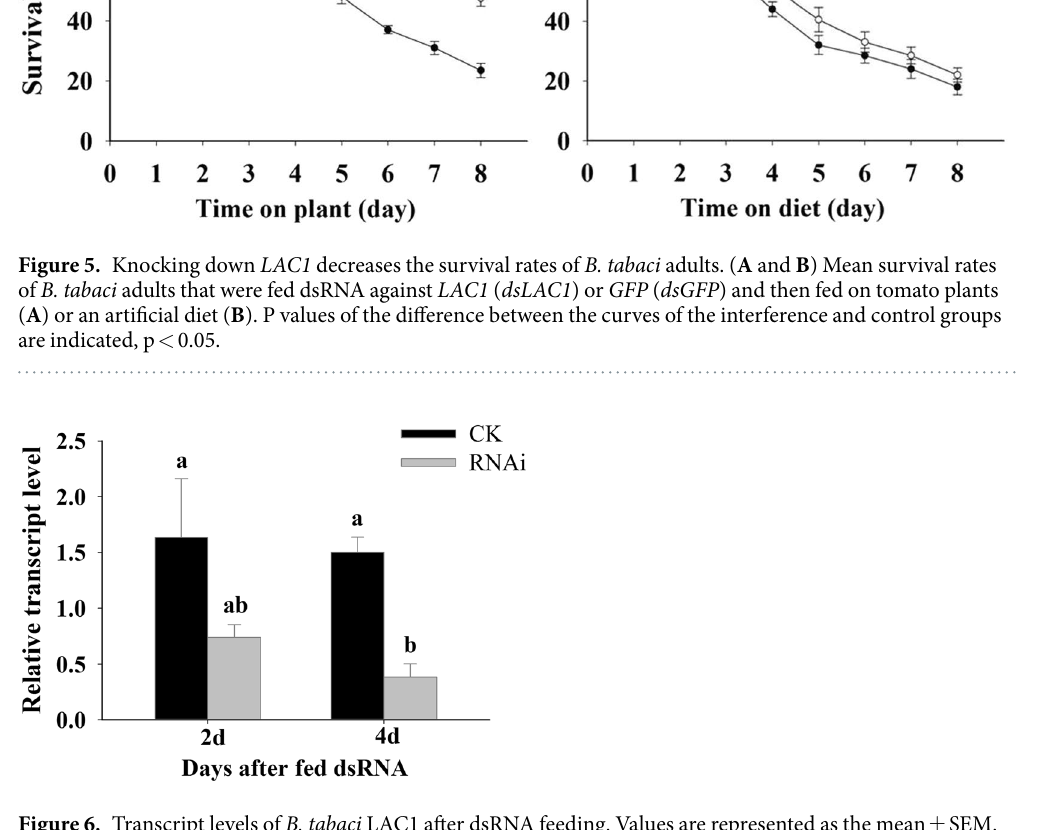
hydrolysed in vivo have not been fully elucidated in insects. To perform its catalytic function, laccase depends on Cu atoms that are distributed at three different copper centres. These copper centres in laccases are cate- gorized into three groups: Type-1 (T1), Type-2 (T2) and Type-3 (T3) 31 . The laccase genes typically have three to four of these copper domains 32 , the structure of which can vary greatly between different organisms. This extensive structural variability results in a corresponding variation in catalytic properties and oxidative func- tion 33–36 , such as their involvement in lignin biosynthesis (in plants) as well as lignin degradation (in fungi and bacteria) 31 . Laccases catalyse the oxidation of a wide array of substrates during four-electron transfer processes while reducing O 2 to water 37 . We found that LAC1 also has three different copper domains: T1, T2 and T3. This structural characteristic demonstrates that LAC1 belongs to the laccase family and has catalytic properties as well as oxidative function. In contrast to most enzymes, which catalyse substrate-specific reactions, laccases oxidize a wide range of compounds that vary from di-, poly-, and substituted phenols to diamines, aromatic amines, and benzenethiols 31, 38 . As laccases have so many kinds of substrates, LAC1 in B. tabaci may perform more than one function in vivo . Phylogenetic analyses comparing the B. tabaci MED LAC1 protein sequence to 37 other LACs from insects, fungi, bacteria, and plants showed that the B. tabaci laccases are evolutionarily unique and distinct from other insect LAC2 proteins with known or suspected roles in integument formation 23, 26, 39 . According to the phyloge- netic analysis, B. tabaci LAC1 is most similar to N. lugens MOX1 (AKN21378.1), D. citri LAC1 (XP_008487811.1), N. cincticeps LAC1 (BAJ06132.1) and A. pisum LAC1 (XP_001948070.1) (Fig. 1). This result illustrated that lac- cases of plant-sucking insects may have similar physiological functions and be evolutionarily related. ABTS is specifically oxidized by laccase 40 . We observed a significant difference in laccase activity between saliva and the control solution, indicating that the ABTS-oxidizing enzyme is laccase. So far, LAC1 is the only